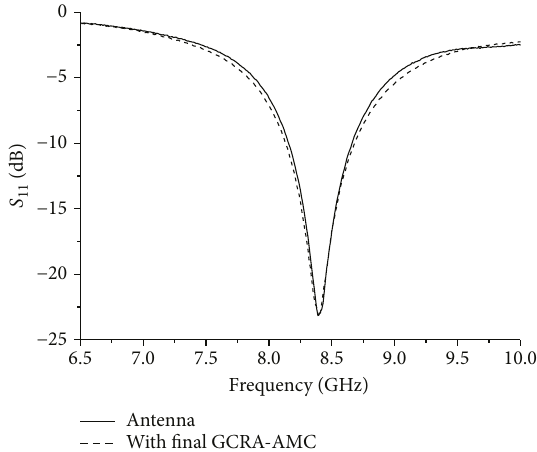
Figure 11: The measured S without fi nal